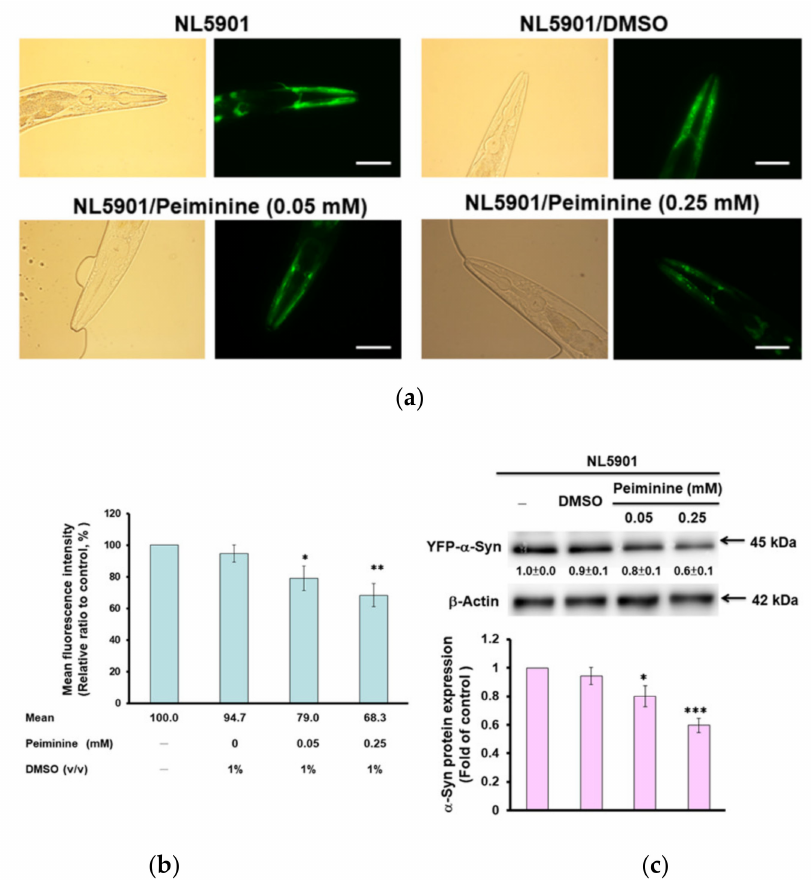
Figure 4. Accumulation of human α -synuclein in muscle cells of NL5901 worms was significantly reduced by treatment with peiminine (PMN). L1 stage NL5901 worms were cultured on OP50/NGM plates with or without PMN for 1 day. The worms were transferred to OP50/NGM/FUDR plates with or without PMN and cultured for 3 days, and then analyzed by fluorescence microscopy. ( a ) Representative YFP fluorescence images of the accumulation of α -synuclein in the head muscles of worms in each group. Scale bar = 50 µ m. ( b ) ImageJ software was used to quantify the fluorescence intensity of YFP of each group ( n = 50) in ( a ). ( c ) The protein levels of α -synuclein in each group were analyzed by Western blotting. The loaded internal control is the level of β -actin. The image shows representative data from one of three independent experiments. The relative ratio is expressed as the ratio of the level of α -synuclein in each group to that in the PMN-untreated group. * Indicates a significant difference between the PMN-treated group and the PMN-untreated group (* p < 0.05, ** p < 0.01, *** p <